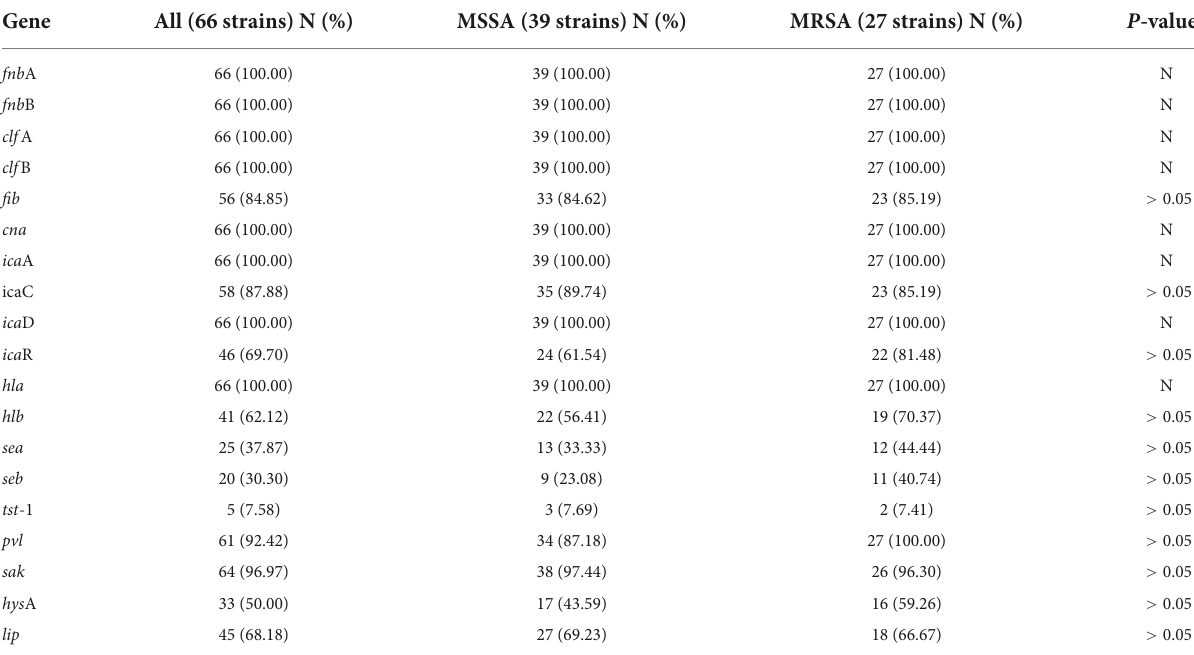
TABLE 5 Carrying rates of virulence genes in 66 invasive Staphylococcus aureus